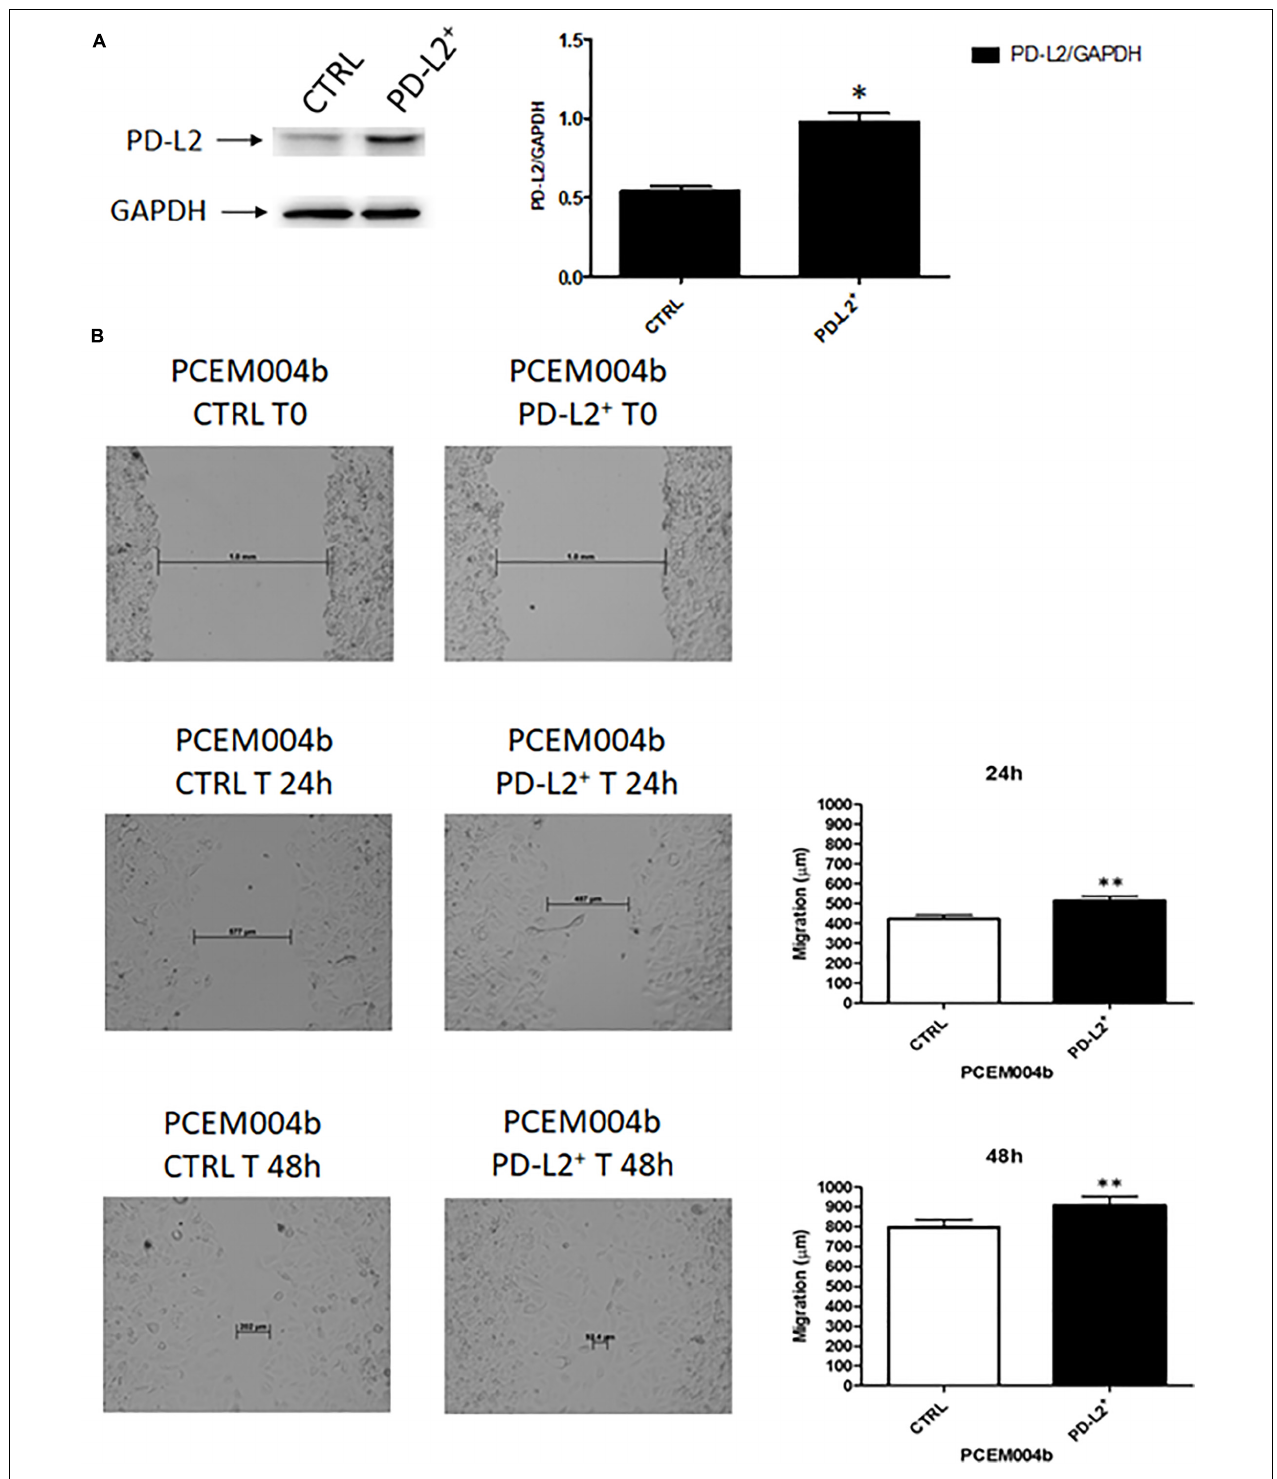
FIGURE 5 | PD-L2 overexpression enhances migration of EC cells. (A) Western blot analysis of PD-L2 and GAPDH protein levels in PD-L2 + PCEM004b cells. Blots are representative of one of three separate experiments. PD-L2 densitometry values were normalized to GAPDH used as loading control. Densitometric values shown are the mean ± SE of three separate experiments. * p < 0.05 vs control cells. (B) Wound healing assays for PCEM004b cells after PD-L2 overexpression. All experiments were repeated three times. T0 h (used for consistency with other time-points). Data are presented as the mean ± SD. ** p < 0.01 vs control.